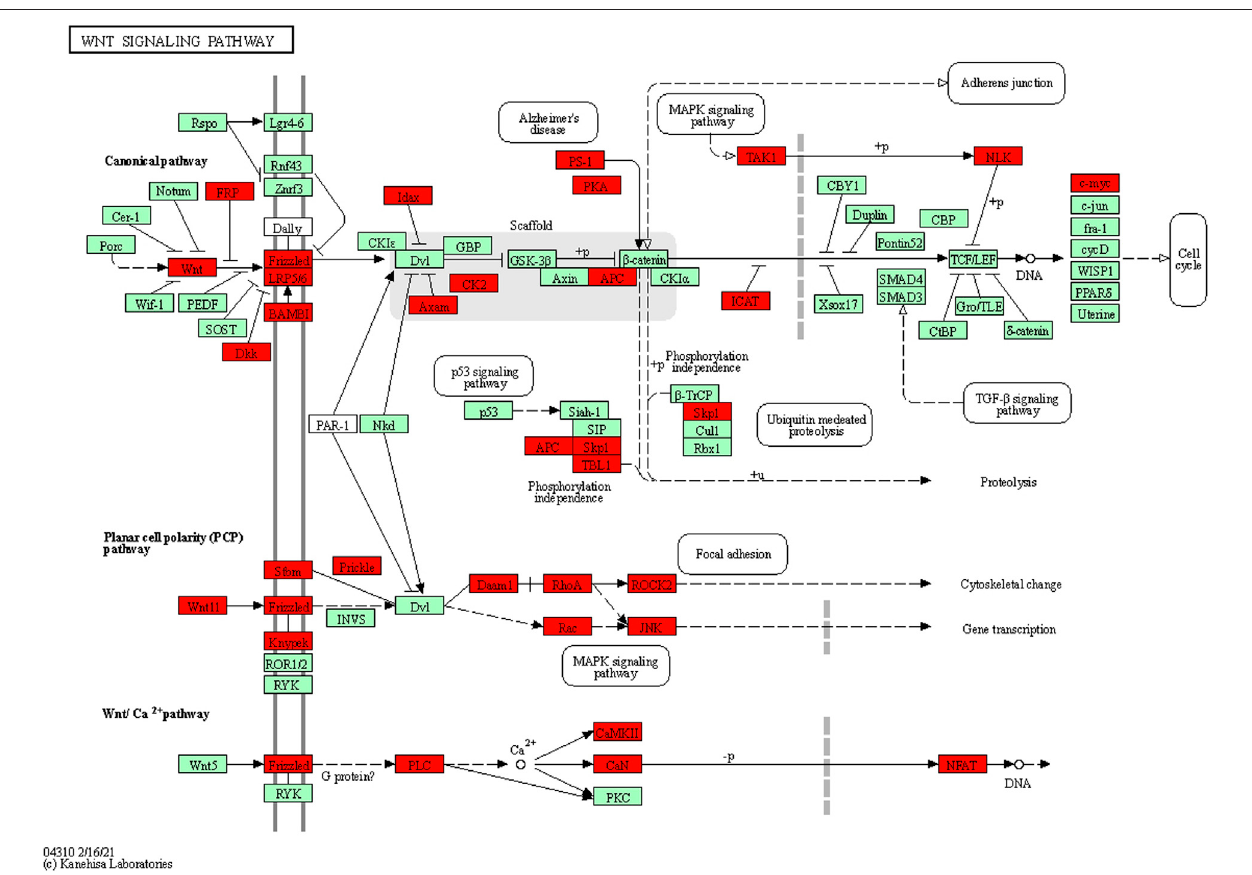
FIGURE 7 | Target genes in the KEGG Wnt pathway map generated using DAVID software. The results indicated that 35 genes (highlighted in red) in the Wnt pathway may be associated with seven differentially expressed miRNAs.